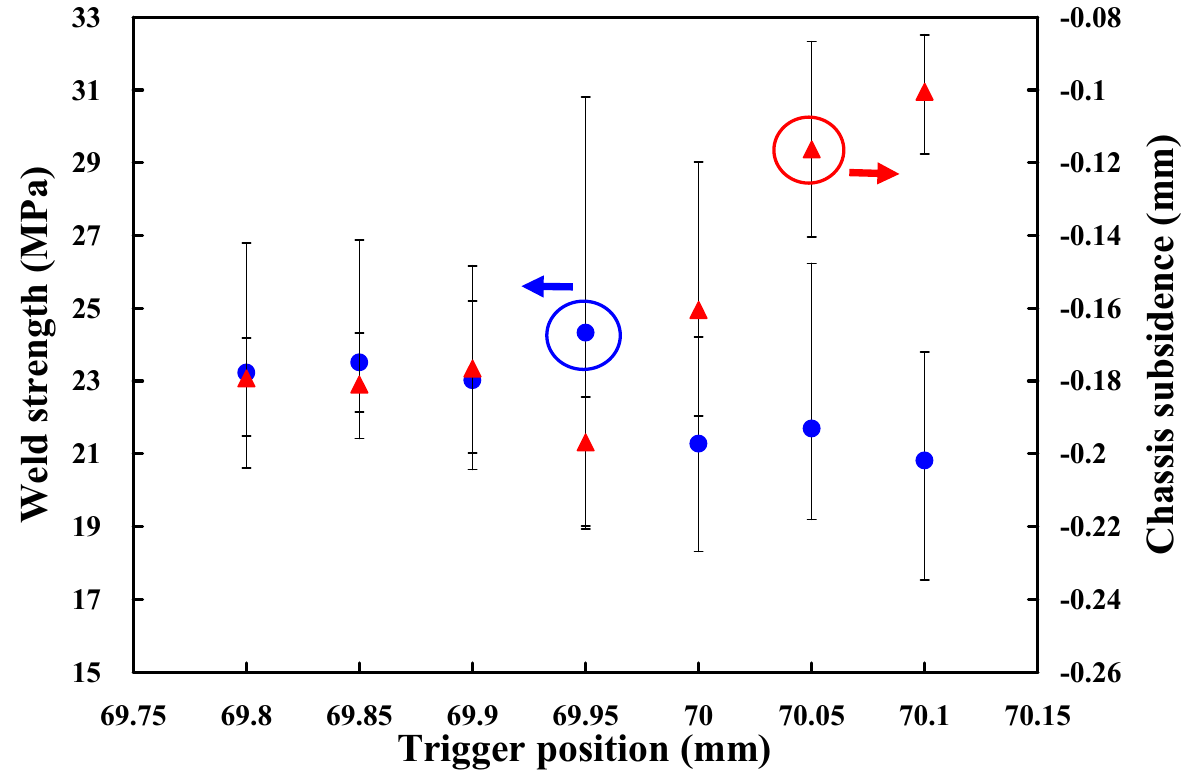
Figure 8. Effects of the different trigger positions on weld strength and chassis subsidence.